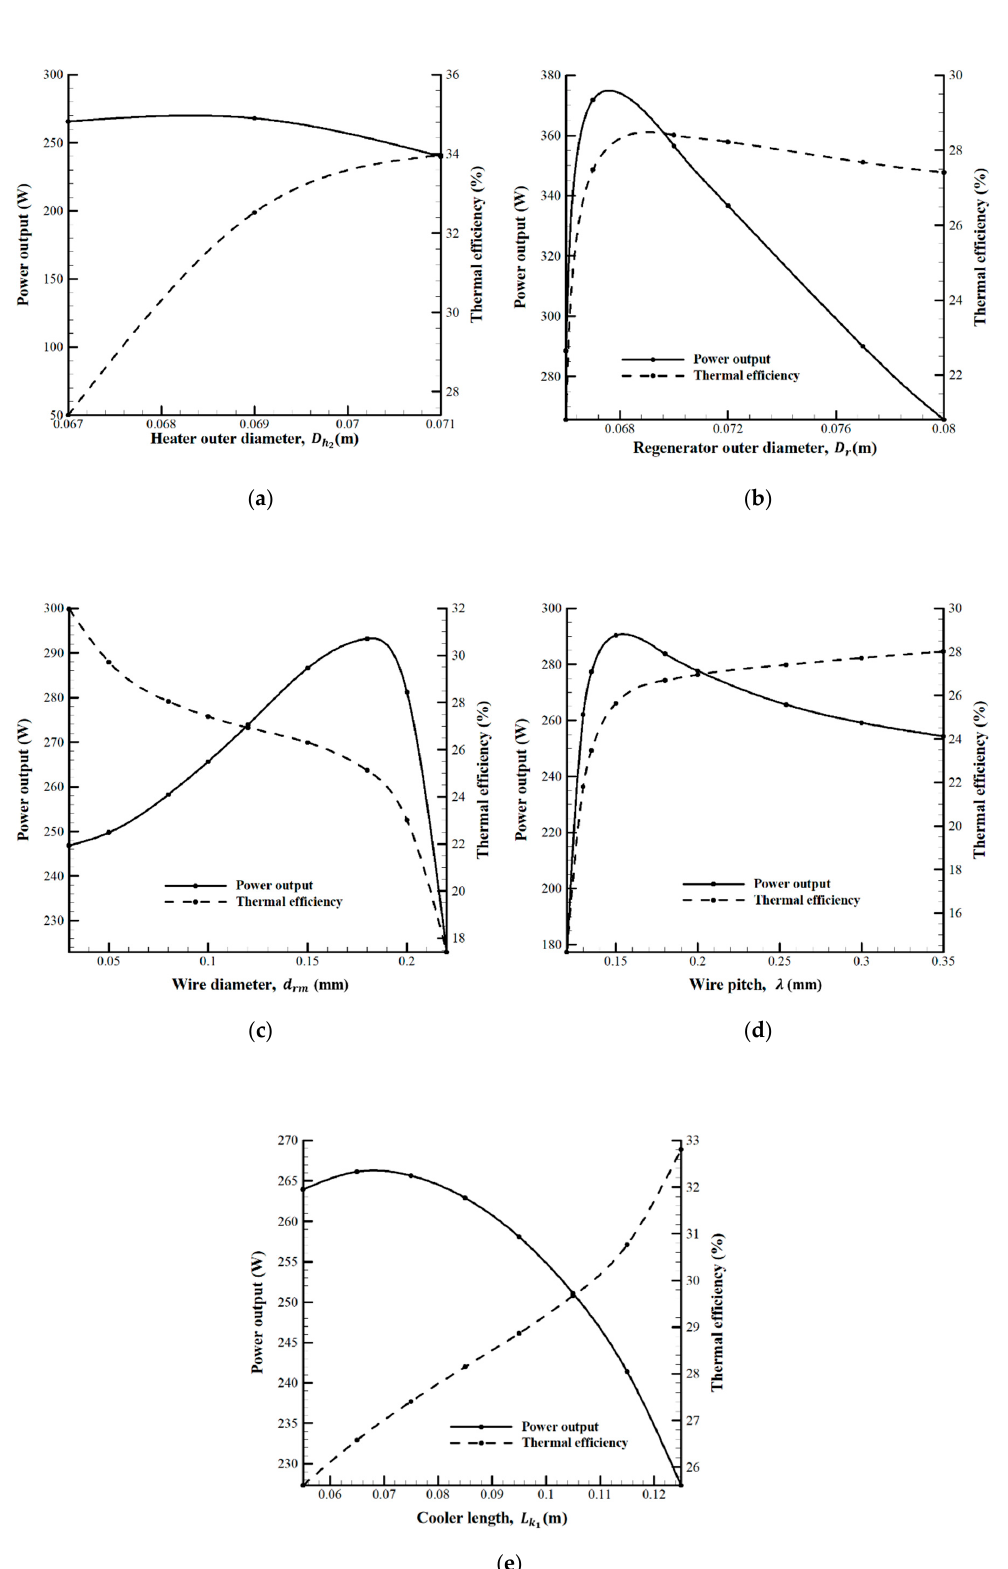
Figure 5. Parametric analysis of the designed parameters. ( a ) Heater outer diameter; ( b ) Regenerator outer diameter; ( c ) Wire diameter; ( d ) Wire pitch; ( e ) Cooler